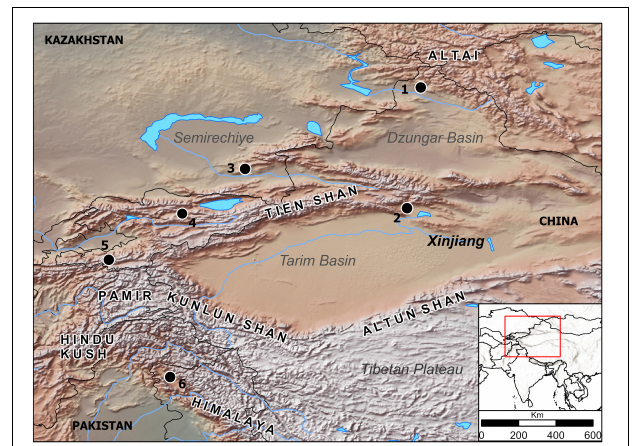
FIGURE 1 | Regional geography, points indicate significant early agropastoralist archaeological sites. (1) Tongtian Cave (Zhou et al., 2020), (2) Xintala (Zhao et al., 2013), (3) Begash (Frachetti et al., 2010) and Tasbas (Doumani et al., 2015), (4) Chap (Motuzaite Matuzeviciute et al., 2019) and Aigyrzhal (Motuzaite Matuzeviciute et al., 2017), (5) Obishir (Taylor et al., 2021), and (6) Pethpuran Teng (Yatoo et al., 2020) and Kanispur (Pokharia et al.,